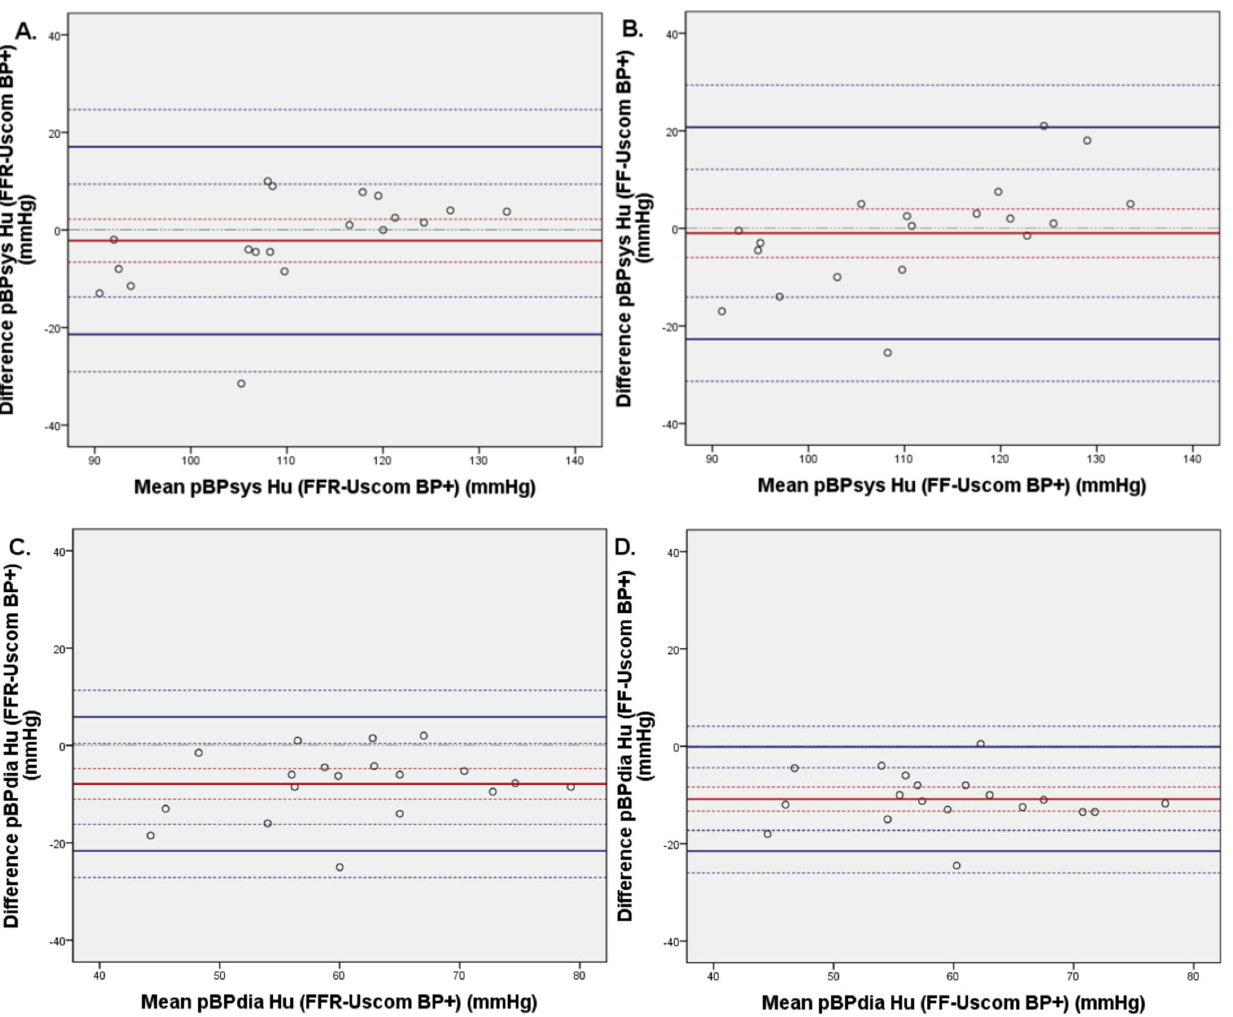
Figure 6. Bland–Altmann plots of systolic ( A , B ) and diastolic ( C , D ) brachial blood pressure comparing non ‐ invasive blood pressure (Uscom BP+ device) to invasive brachial blood pressure (with FFR wire on the left side and with FF catheter on the right side) ( n = 20).